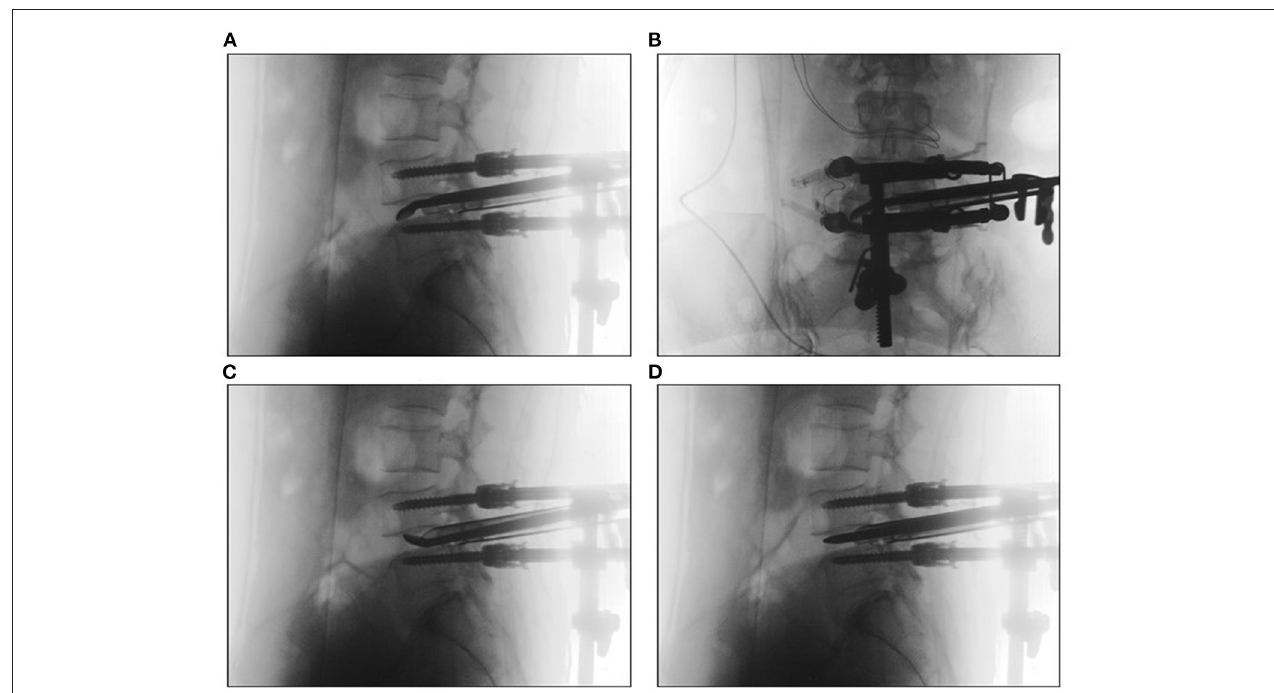
FIGURE 3 | Endplate preparation was performed with various tools through an expandable tube (A–D) .